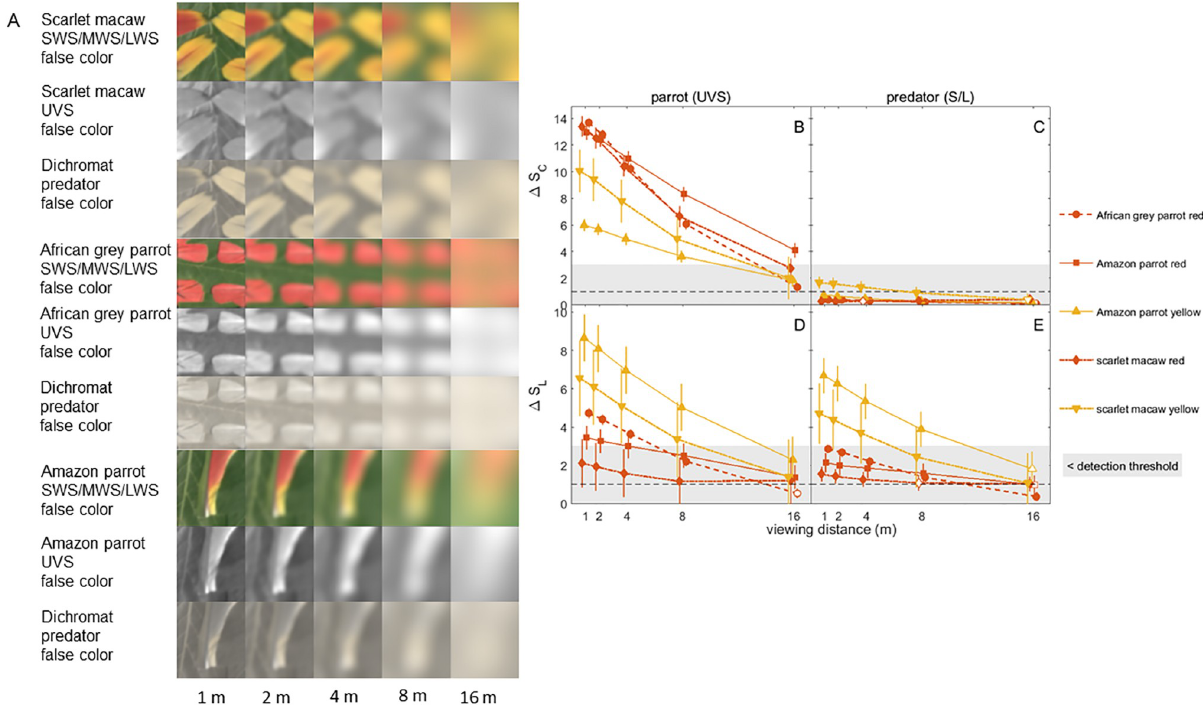
Fig 9. False color images and color and brightness contrast analysis of parrot feathers. (A) False color images in parrot ultraviolet sensitive (UVS) and dichromatic mammalian predator vision of scarlet macaw, African grey parrot and Amazon parrot red and yellow feathers vs green leaf for different viewing distances. (B)-(E) Color and luminance contrasts for parrot feather colors relative to green vegetation, over a range of viewing distances. See Fig 6 caption for further details.